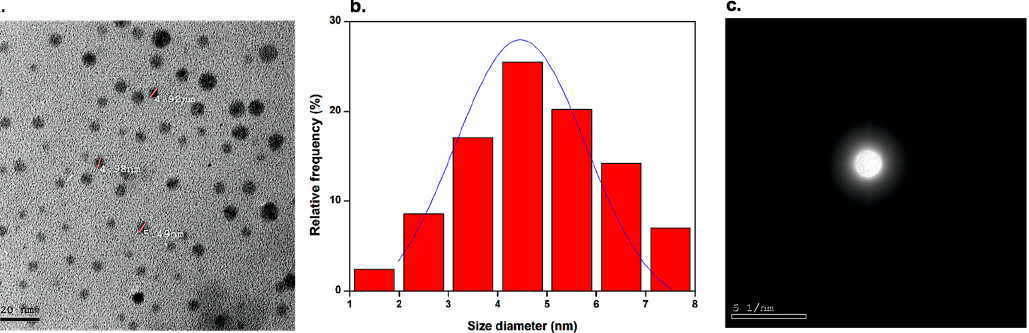
Figure 1. ( a ) Transmission electron microscope (TEM) image at the scale of 20 nm, ( b ) size distribu- tion histogram, and ( c ) selected area electron diffraction (SAED) pattern of the BCDs nano-biocar-